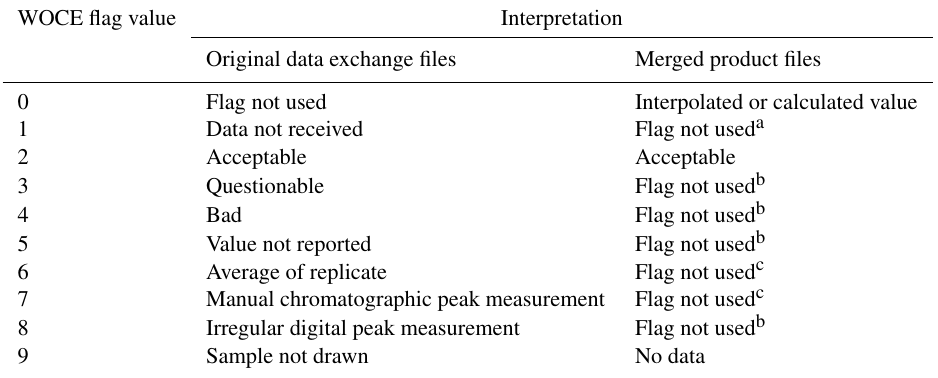
Table 2. WOCE flags in GLODAPv2.2022 exchange-format original data files (briefly; for full details see Swift, 2010) and the simplified scheme used in the merged product files.